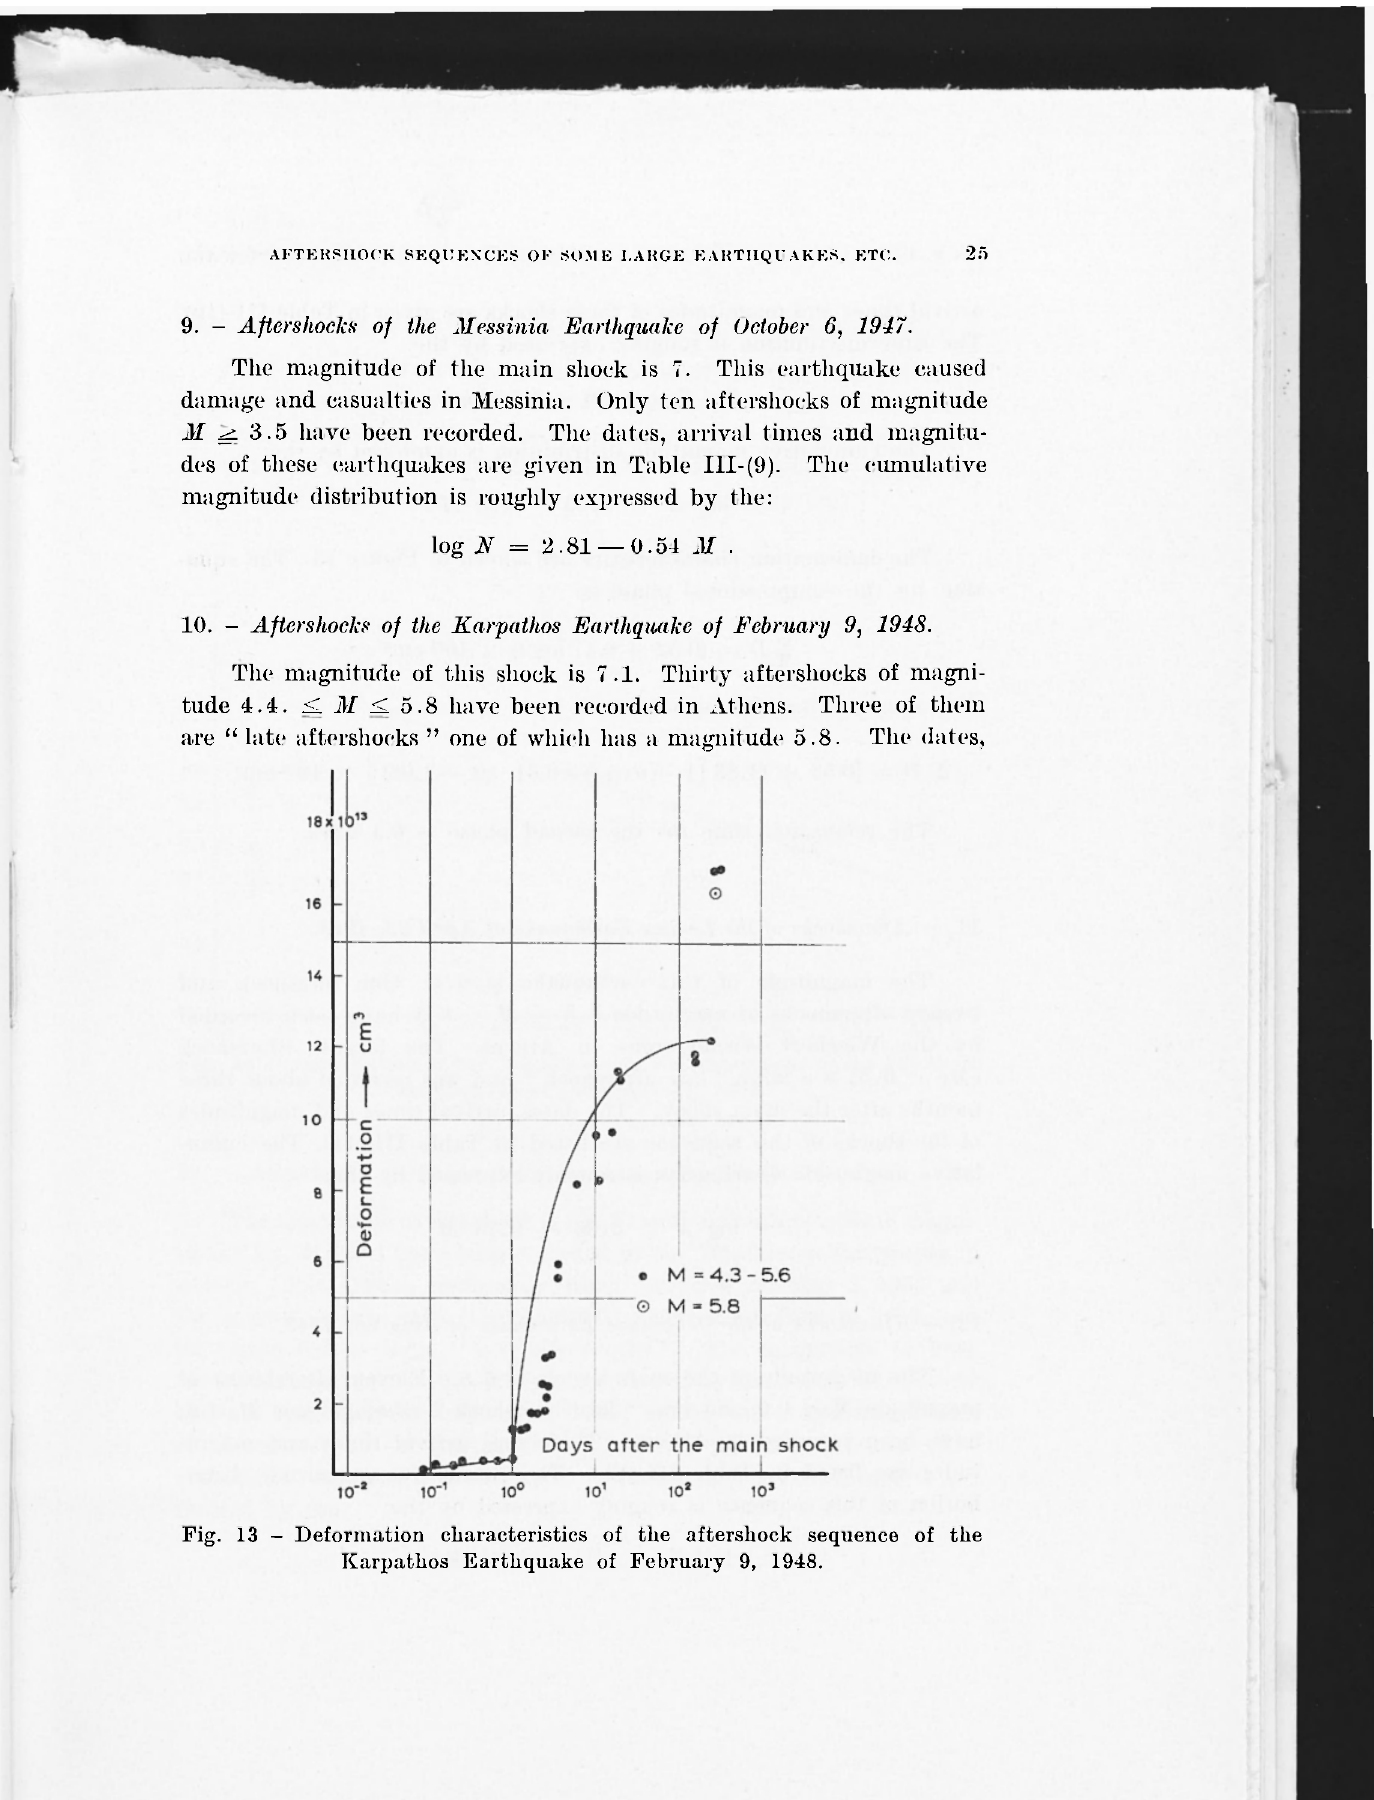
Fig. 13 - Deformation characteristics of the aftershock sequence of the Karpathos Earthquake of February 9,